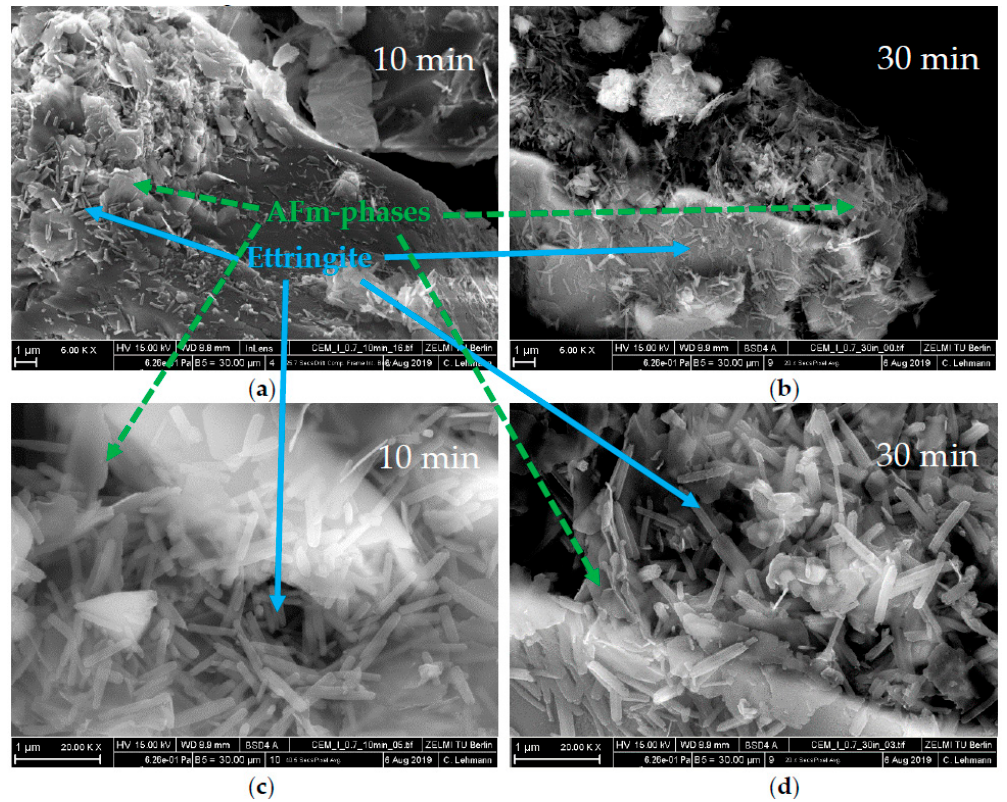
Figure 11. SEM images of CEM I with 0.7 wt% of SP (direct addition) and a w/c ratio of 0.36 after a time of ( a , c ) 10 min and ( b , d ) 30 min.